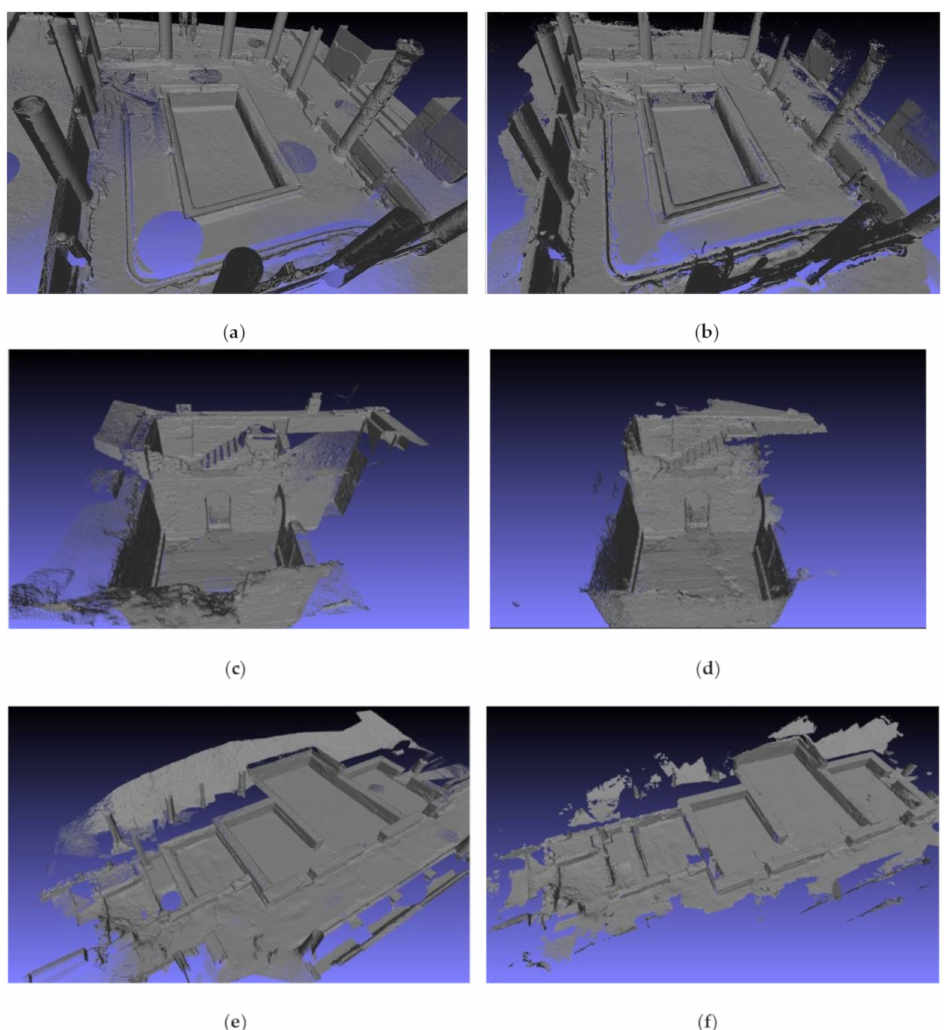
Figure 8. Comparison of the point cloud resulting from the LS Faro Focus3D X 330 ( a , c , e ) and the proposed system ( b , d , f ) of working area 1 ( a , b ), working area 2 ( c , d ), and working area 3 ( e , f ). Visualization was carried out in Meshlab [52] with a homogeneous normal calculation for both systems, with the aim of eliminating textures and favoring a balanced geometric